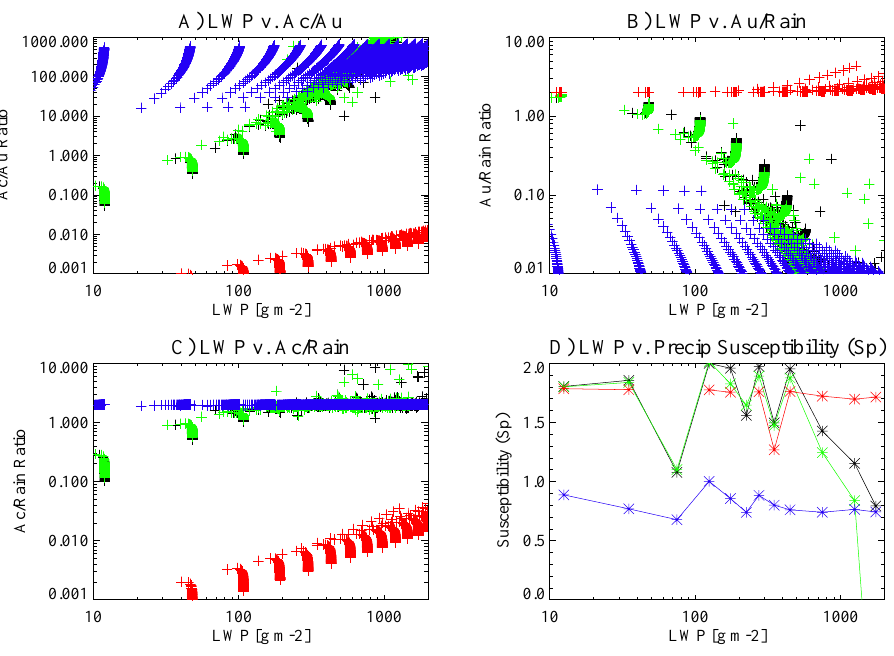
Fig. 3. Results from steady-state model of Wood et al. (2009). (A) LWP vs. accretion to autoconversion ratio ( A c /A u ), (B) LWP vs. autocon- version to rain rate ( A u /Rain), (C) LWP vs. the ratio of accretion to rain rate ( A c /Rain) and (D) LWP vs. Precipitation Susceptibility. Cases shown: the base case (Black), case with sub-grid variability (Qcv = 2) in green, diagnostic rain case (DiagQr, Red), and diagnostic rain with vertical variation of rain rate from autoconversion (DiagQr 0 . 5 : Blue) as described in the